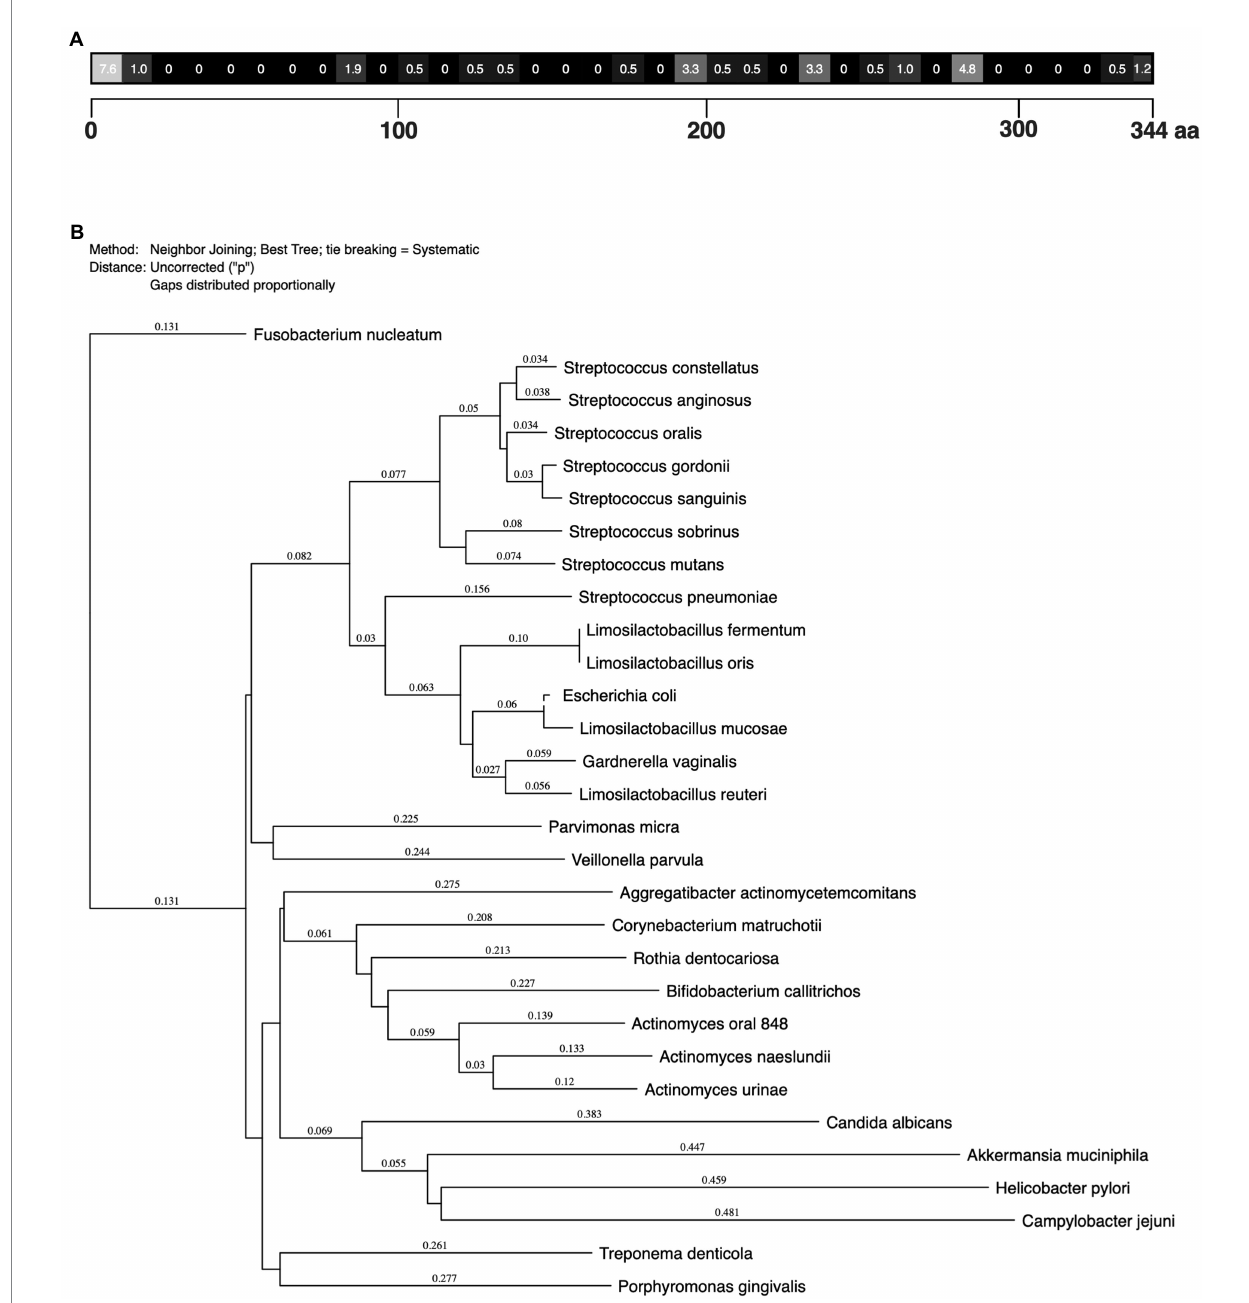
FIGURE 1 Limosilactobacillus fermentum MdpL alignment and the degree of protein sequence conservation. (A) Numbers display the percentage (%) of changed amino acids in a block of 10 amino acids, compared to MdpL from one selected L. fermentum strain (GenBank: WP_057727250.1). (B) Phylogenetic tree of MdpL and related proteins from other species. The number above the branch points denote the confidence level of the relationship of the paired sequences determined by boot strap statistical analysis. The tree is not drawn to